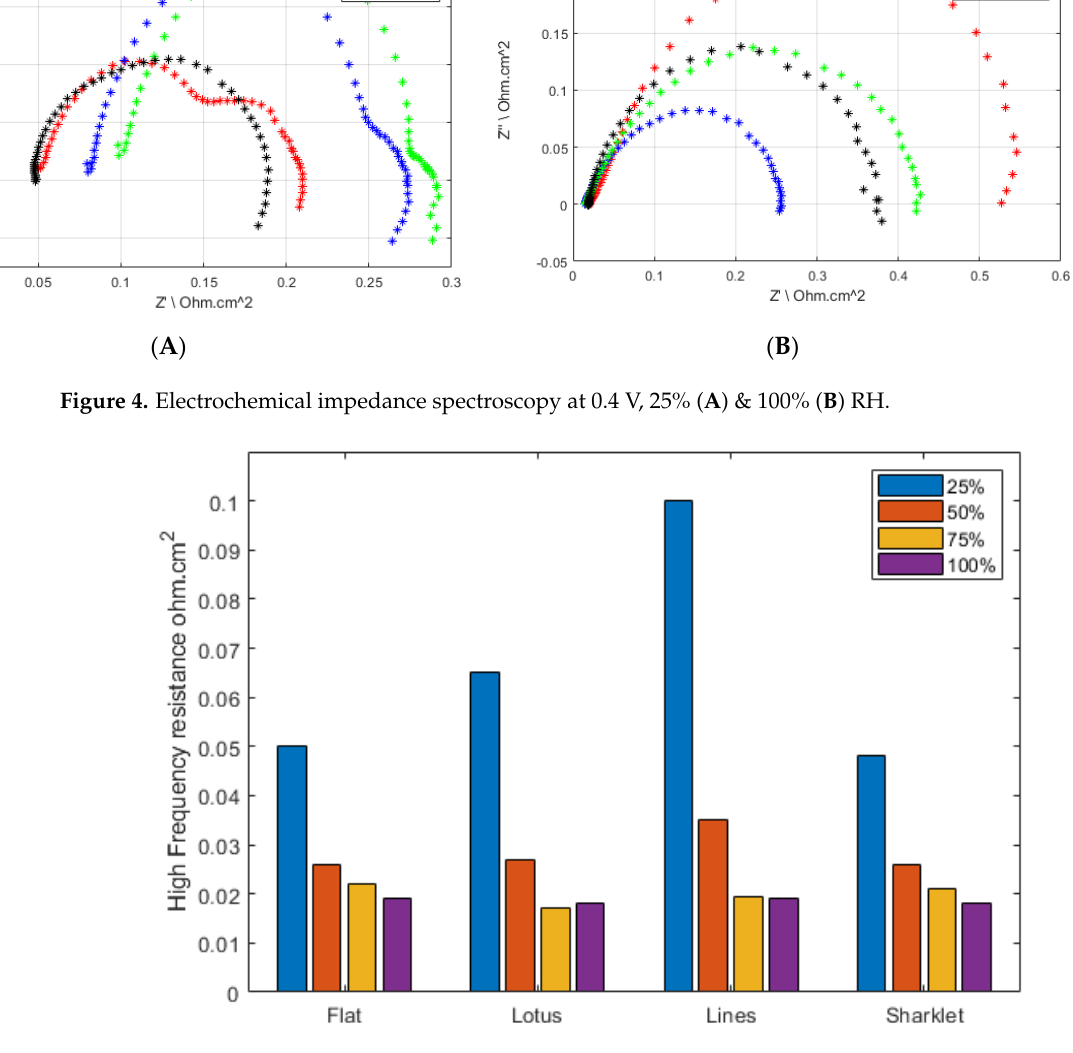
Figure 6. Hydrogen crossover for each pattern at different humidity levels.